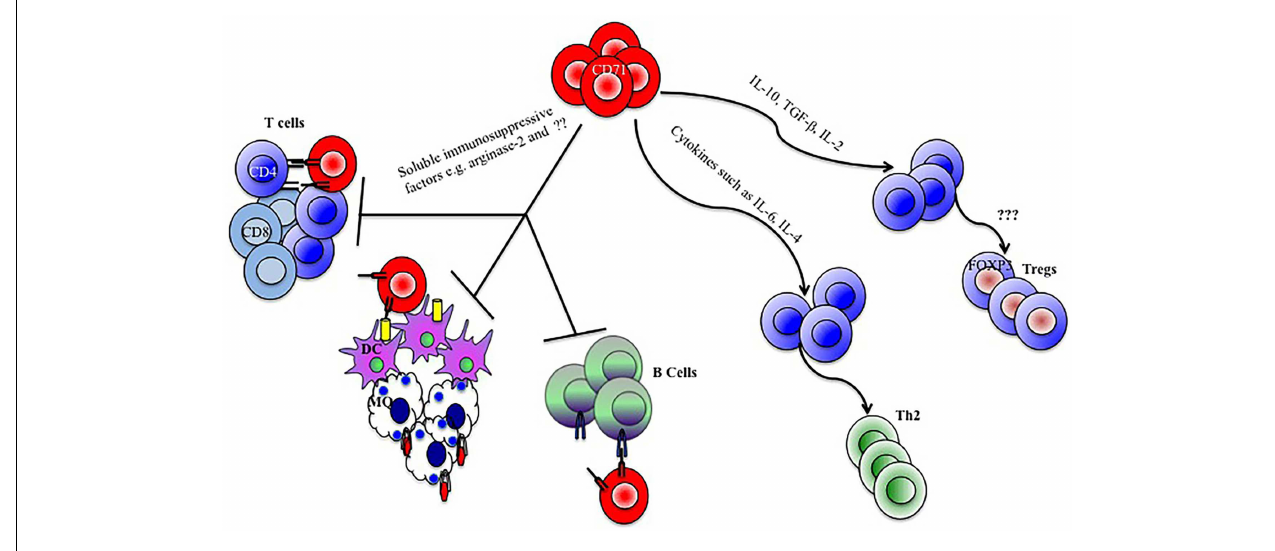
and dendritic cell (DC) responses. CD71 + erythroid cells could also skew aTh2 type immune response or expand regulatoryT cells (Tregs), by the production of cytokines and influence on the cytokine